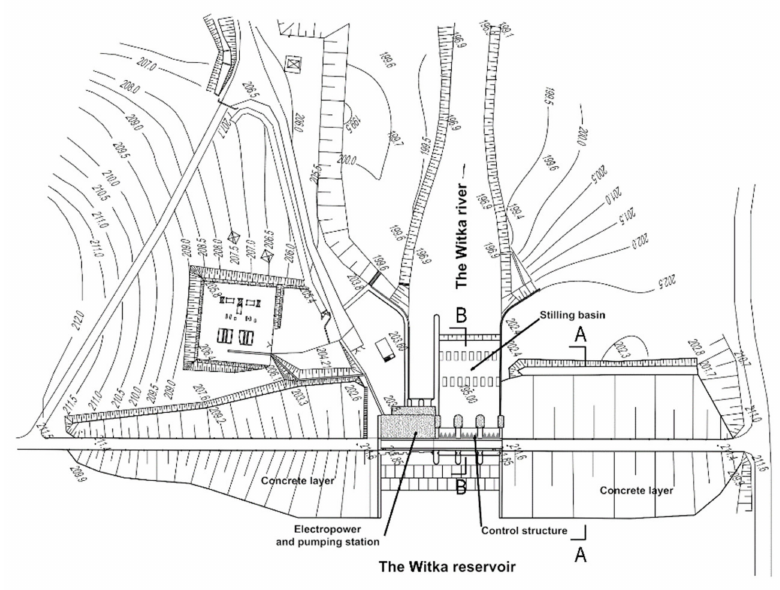
Figure 2. Plan view of the Nied ó w Dam.